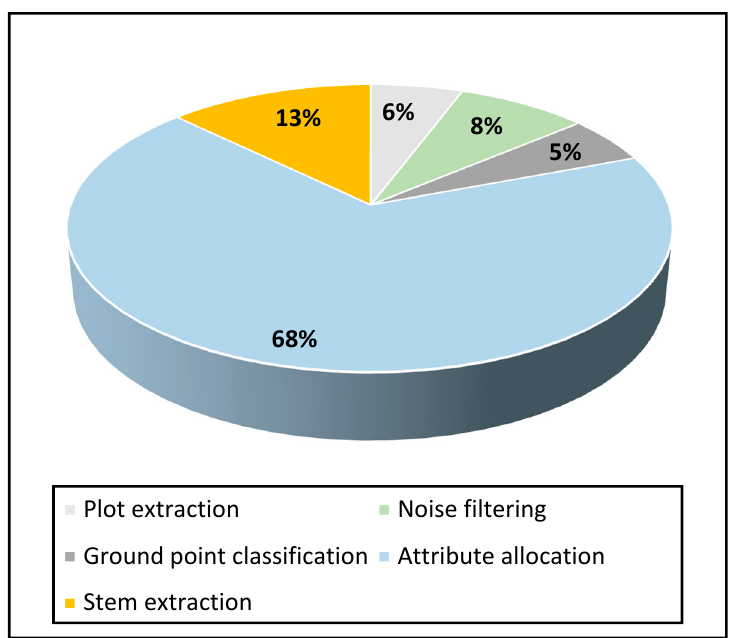
Figure 5. Analysis of time spent on each process in office work with BPLS data (%) .